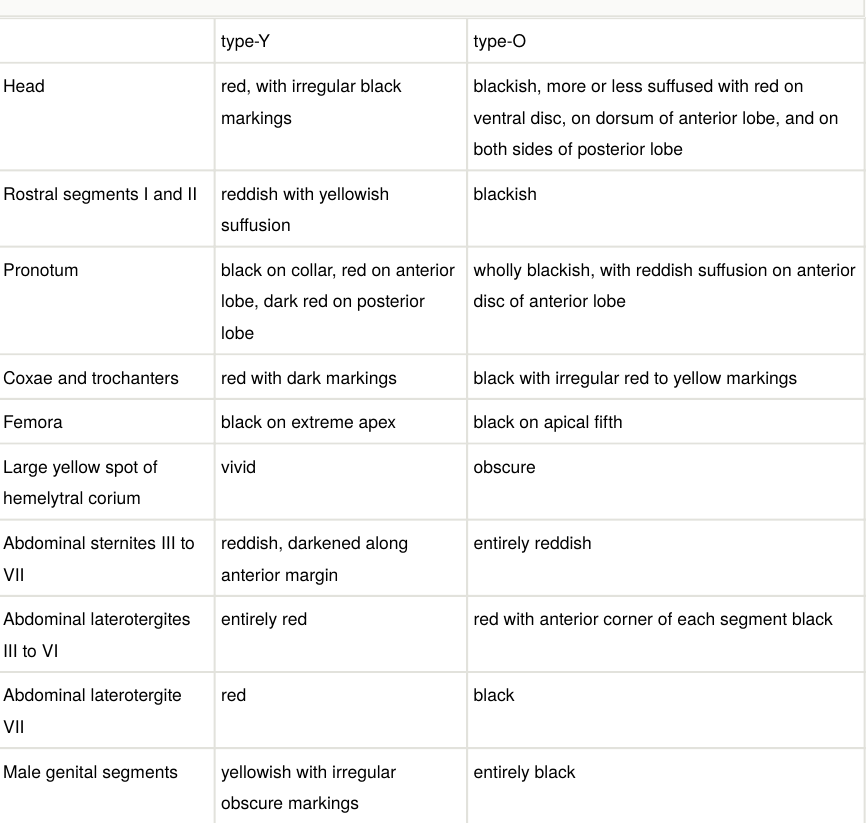
Table 1. Di ff erential diagnosis of type-Y. and type-O of Tiarodes miyamotoi Ishikawa, Cai and Tomokuni, 2005